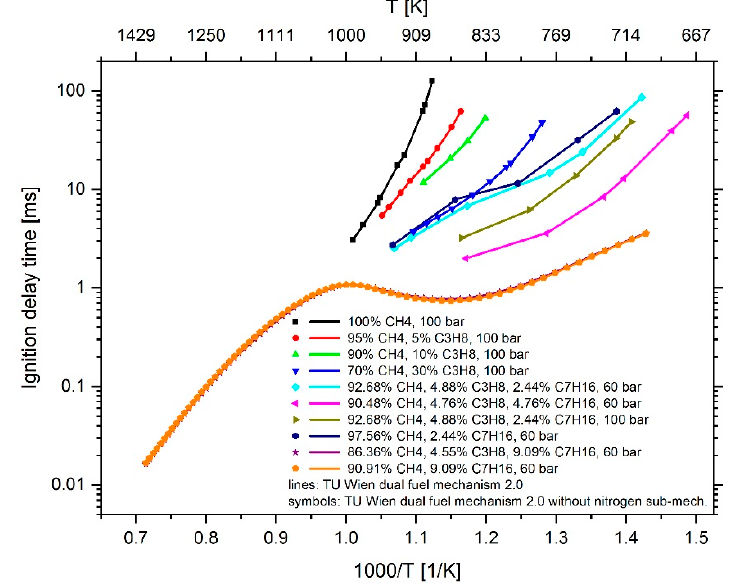
Figure 24. IDT simulation with the TU Wien dual fuel mechanism 2.0 (lines) and the TU Wien dual fuel mechanism 2.0 without the nitrogen sub-mechanism (symbols). The respective content of methane, propane and n -heptane is given in mol% and corresponds to the values in Table 1.